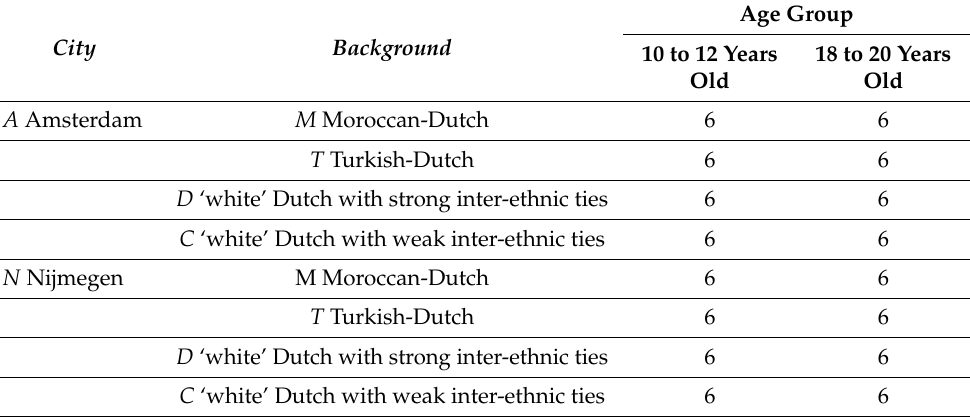
Table 1. Speaker design of the Roots of Ethnolects project.